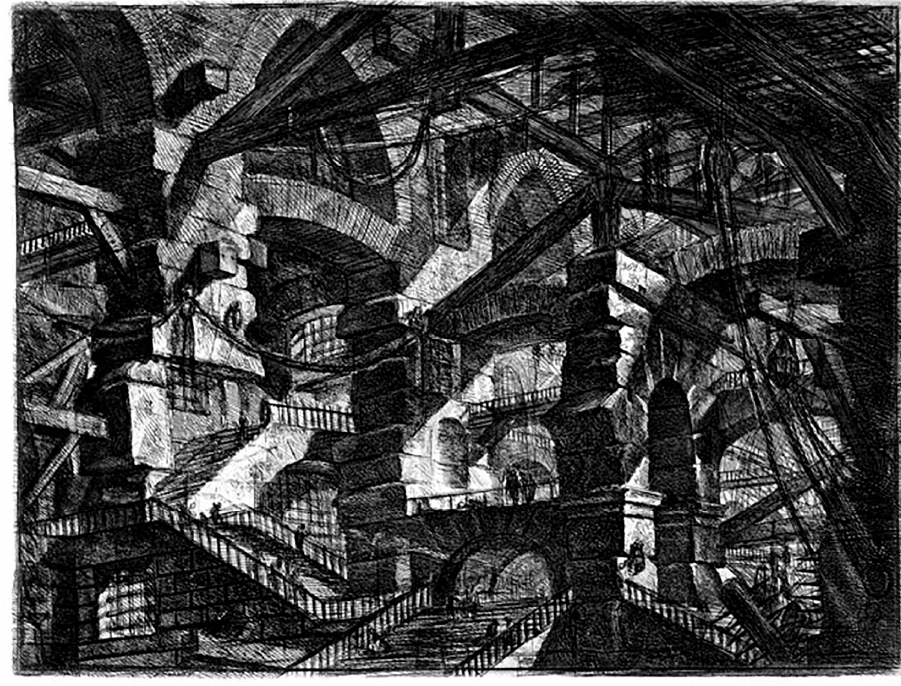
Figure 1. Giovan Battista Piranesi, The Prisons , 1761.